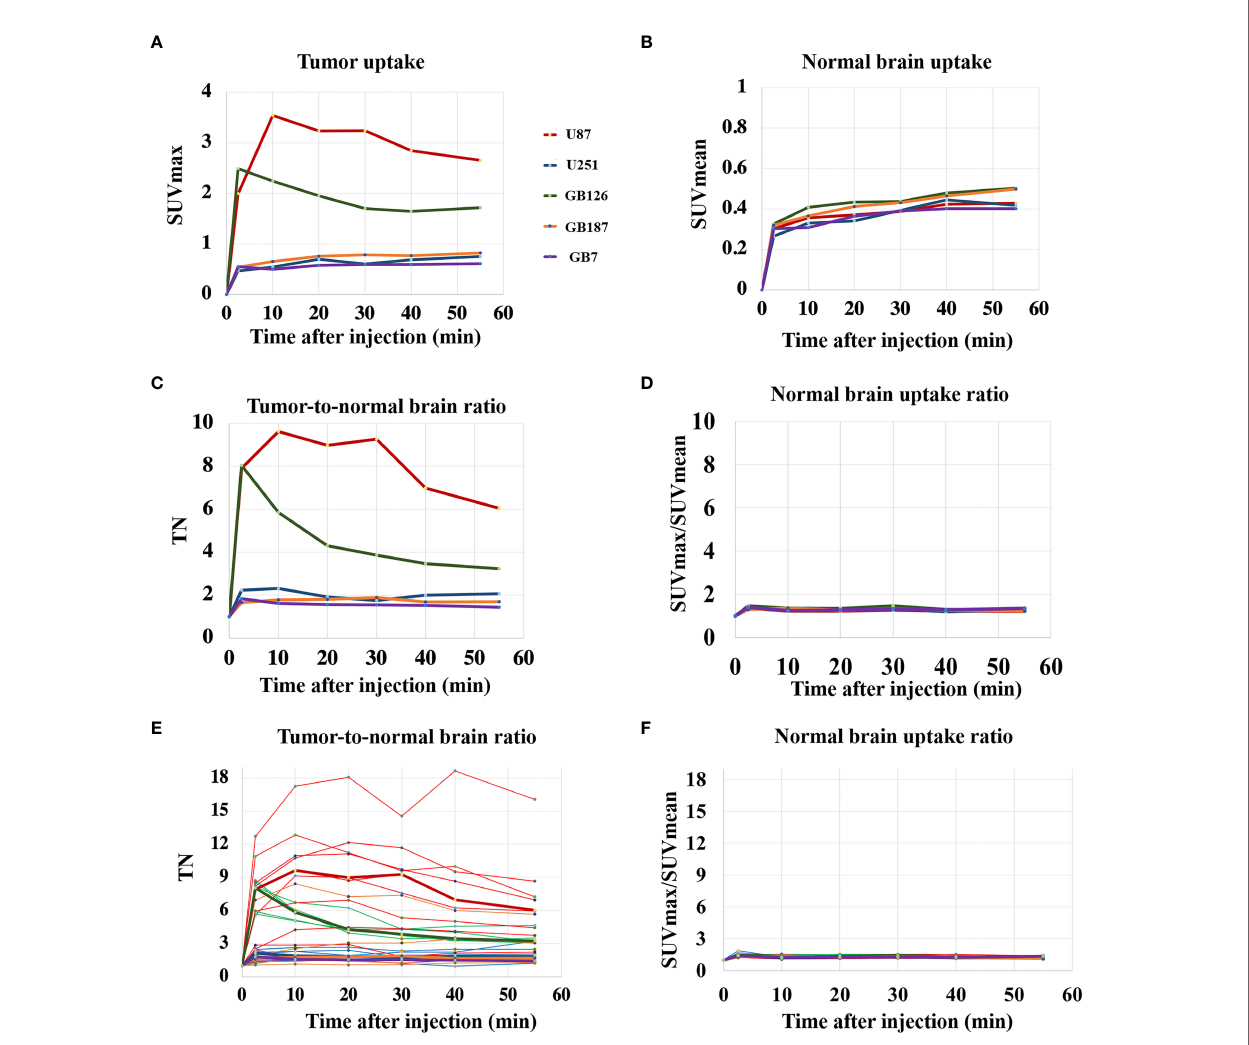
FIGURE 1 | (A) PET uptake curves showing median tumor SUVmax for each tumor line. (B) PET uptake curves showing median contralateral brain SUVmean for each tumor line. (C) PET uptake curves showing median tumor-to-normal brain uptake ratio (TN) for each tumor line. (D) PET uptake curves showing the median normal brain SUVmax/SUVmean ratio for each tumor line. (E) PET uptake curves showing TN for all tumors, including the median lines for reference. (F) PET uptake curves showing the normal brain SUVmax/SUVmean ratio for all